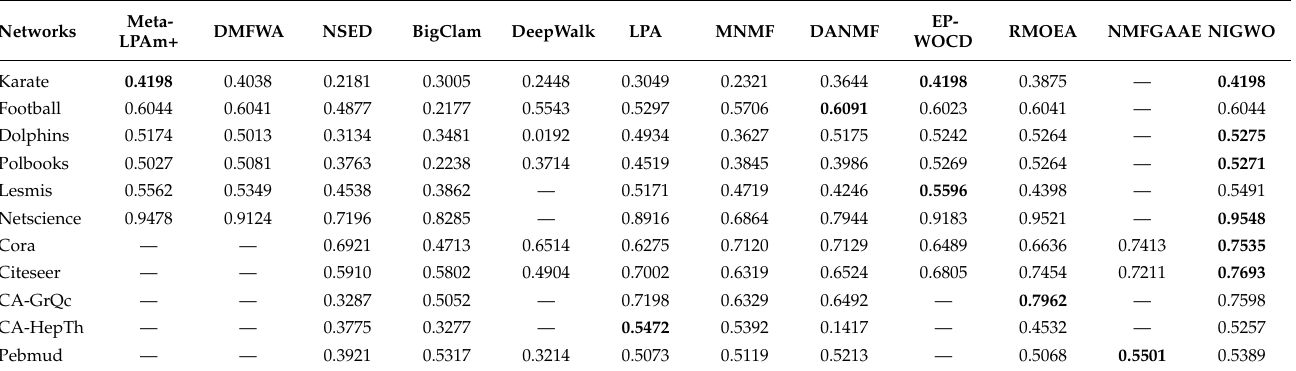
Table 5. Modularity values comparison between algorithms.